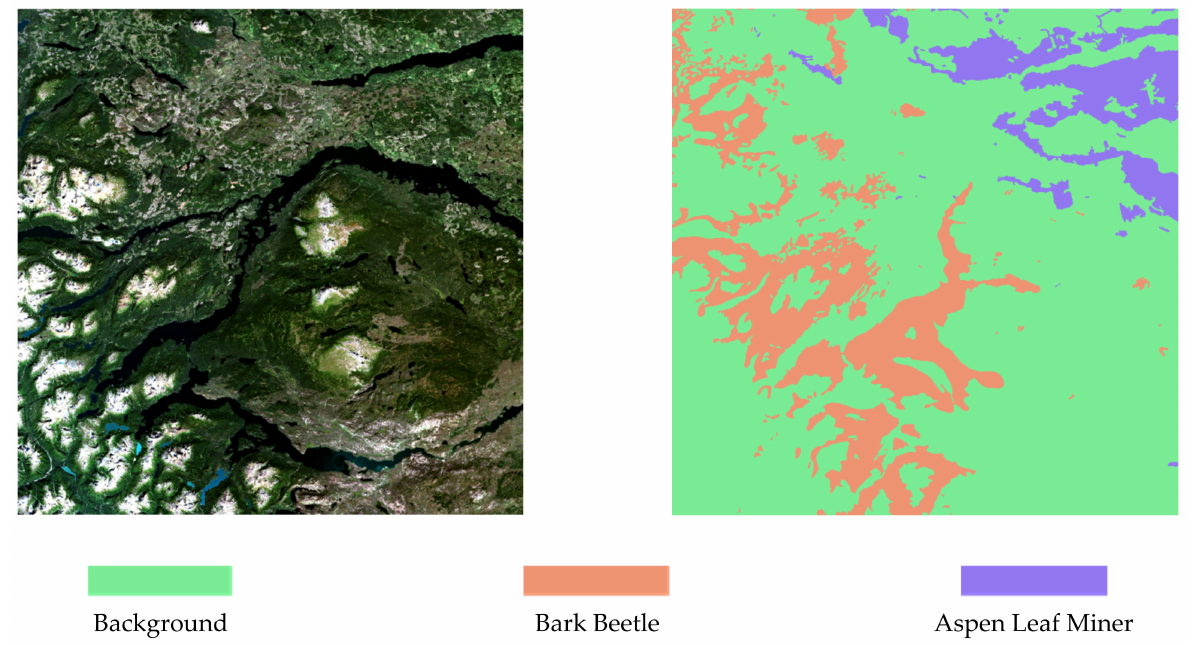
Figure 2. The raster label corresponding to the Sentinel-2